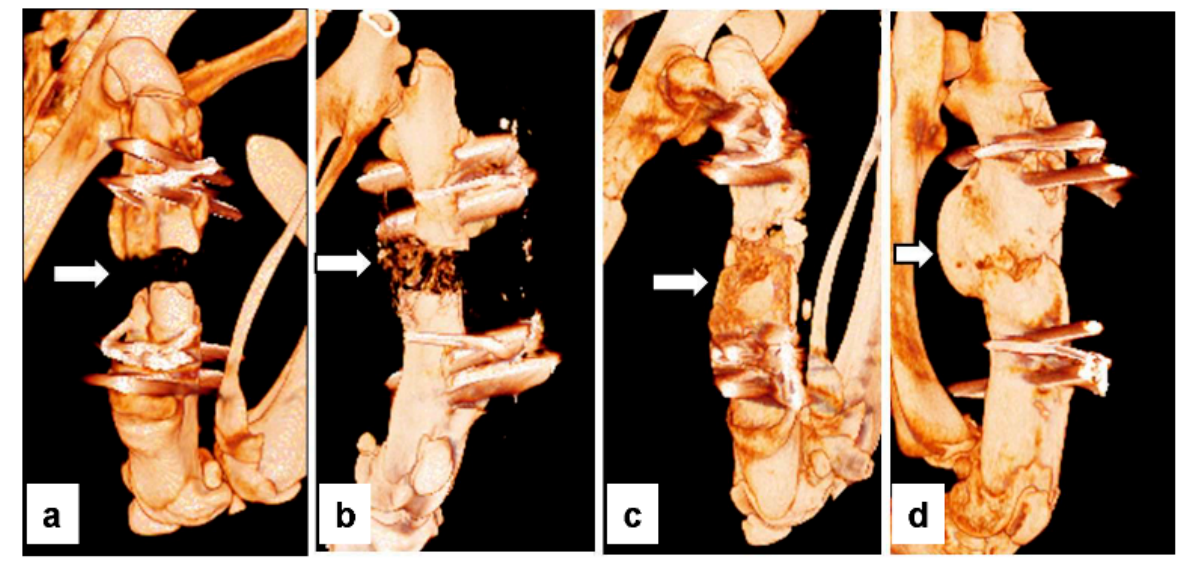
Figure 4. 3D reconstruction images showing bone formation at the femoral defect sites in each group. ( a ) group I (Control), ( b ) group II (DFDB graft), ( c ) group III (Autograft), and ( d ) group IV (BMP). No bony tissue was found in the femoral defects in group I, a small amount of bony tissue was found in group II, a large amount of bony tissue was found in group III, and the largest amount of bony tissue was found in group IV. Table 3. Bone structure parameters–Micro CT. Bone morphometric parameters of healing of the defect sites in the femur. Data presented as mean ± SD (one-way ANOVA, p < 0.05. Posthoc test with Scheffe, bone volume (BV) group I vs. group II, p = 0.304; group I vs. group III, p = 0.005; group I vs. group IV, p < 0.001; group II vs. group III, p = 0.026; group II vs. group IV, p < 0.001; group III vs. group IV, p = 0.06; bone volume/tissue volume (BV/TV) group I vs. group II, p = 0.005; group I vs. group III, p < 0.001; group I vs. group IV, p = 0.0034; group II vs. group III, p < 0.001; group II vs. group IV, p = 0.026; group III vs. group IV, p = 0.25).